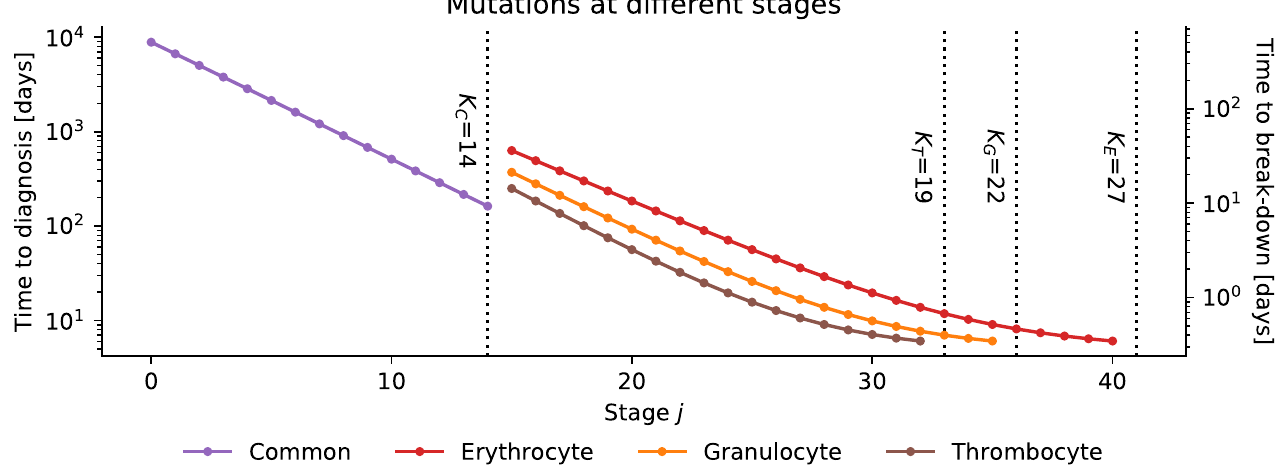
Fig 9. Time course of leukemia. Mutations for unlimited replication and a differentiation block are introduced at stage j at time zero. The time until leukemia is diagnosed is set to the time point when there are half as many mutated cells expected in the bone marrow as normal cells in steady state. This time is shown on the left y-axis. On the right y-axis the time from the diagnosis to the expected break-down of the bone-marrow is shown. This time point is assumed to be reached when there are twice as many mutated cells in the bone marrow as normal cells in steady state.